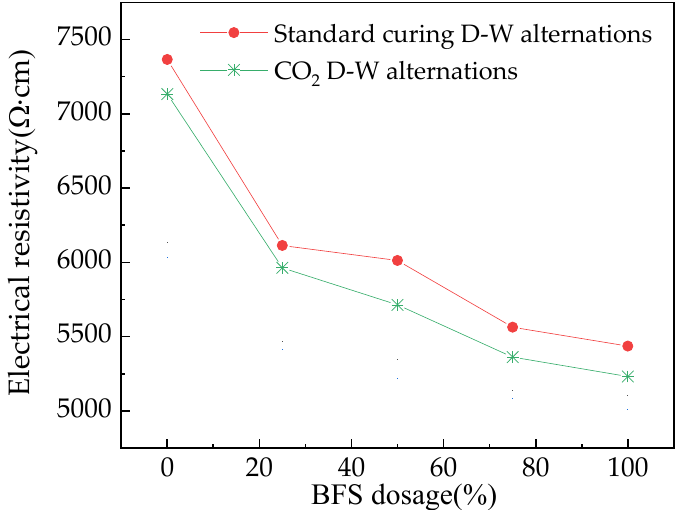
Figure 11. The electrical resistivity of the rust through an equivalent circuit diagram.